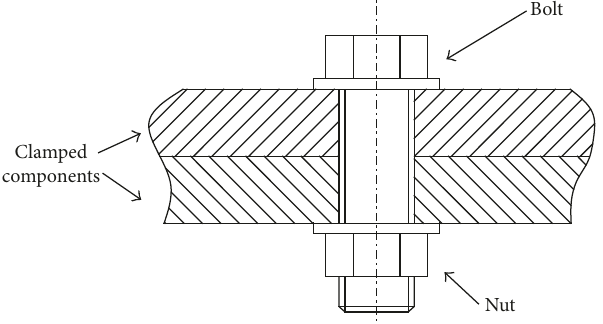
Figure 1: A typical bolt joint